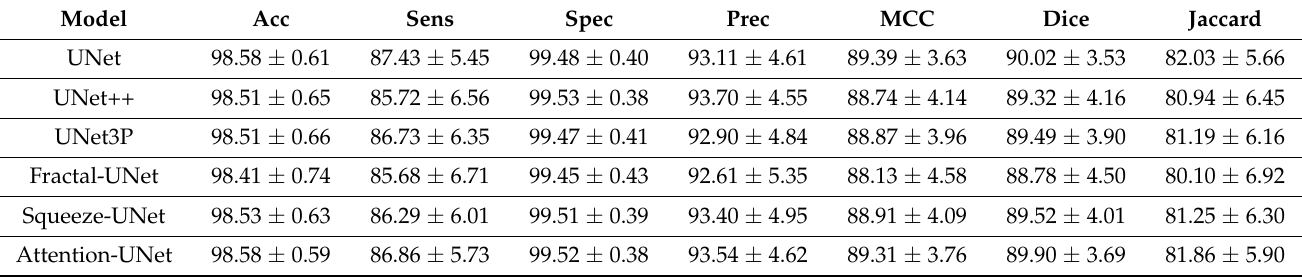
Table 3. Segmentation performance (in %) of all UNet models using ICA database DB1.